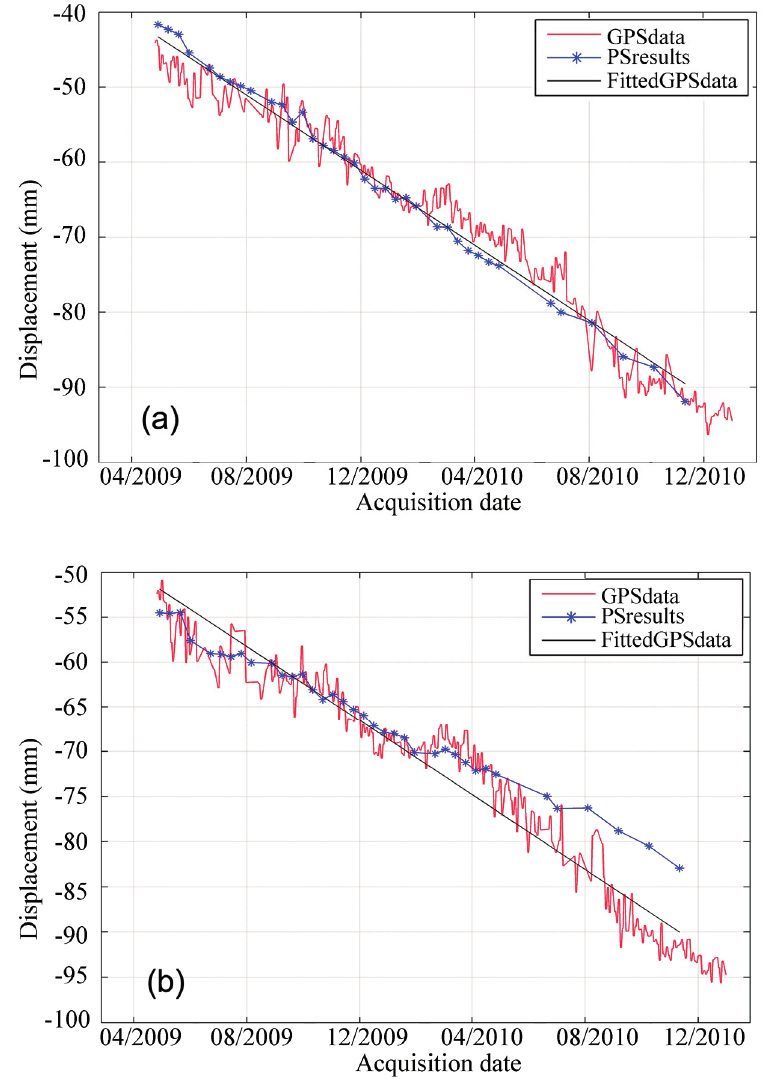
Figure 7. Comparison between PS analysis results and GPS-measured displacement time series projected along the LOS direction. The red line represents the GPS measurement and black line means the fitted GPS data by linear fitting while the blue * are the LOS displacement measured by TSX PS analysis. ( a ) Comparison on Wuqing CORS station; ( b ) Comparison on Jinghai CORS